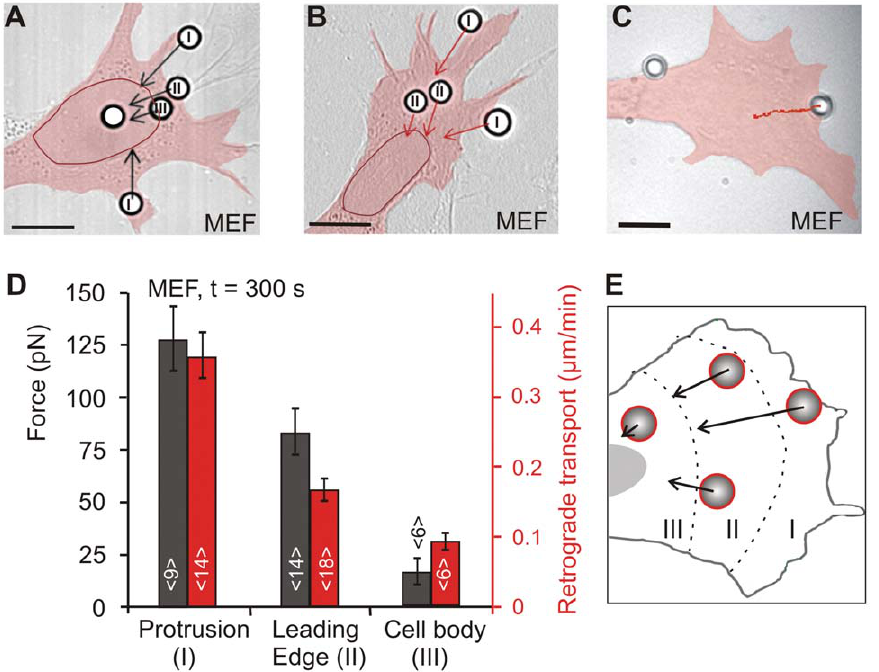
Figure 3. Mapping of traction force and velocity onto the cell surface. A) and B) DIC images of FN-beads deposited at various positions onto the surface of MEF cells. The cell surface is classified into three areas with area I referring to cellular protrusion, area II to the leading edge and area III to the cell body. A) For force measurements beads were positioned onto the cell surface and optical traps were operated with a predefined trap stiffness of 0.160 pN/nm for a time course of 5 minutes. Black arrows denote the direction and magnitude of cellular traction forces. B) For measurements of retrograde transport velocities, beads were positioned by optical traps onto the cell surface, traps were switched off after 5 seconds, and bead movements were recorded in a time lapse movie. Red arrows denote the direction and velocity of retrograde transport. C) Example trajectory of an individual bead positioned in area I (a pseudocolored overlay was added to highlight the outline of the cells and the nucleus was traced by a red line; scale bar=10 m m). D and E) Forces and retrograde transport velocities are position-dependent and correlate with each other (N=5).